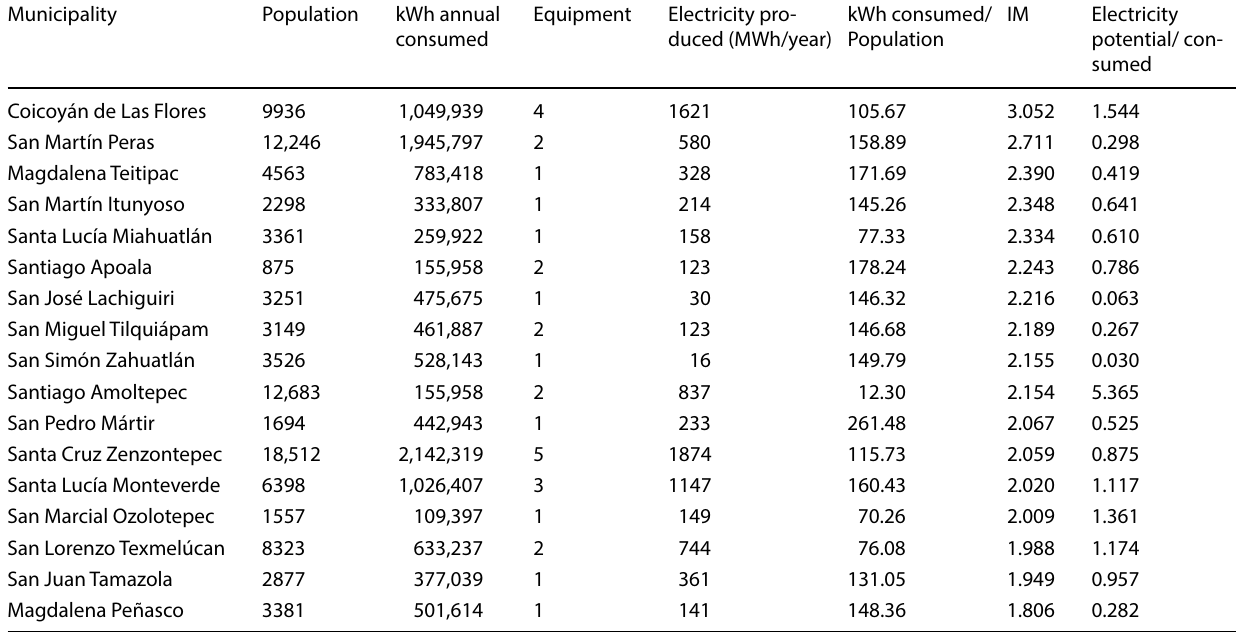
Table 8 Extract for Oaxaca state, municipalities sample Municipality Population kWh annual